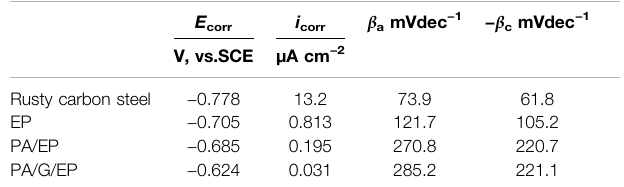
TABLE 2 | Corrosion parameters of rusty carbon steel, EP, PA/EP, and PA/G/EP immersed in 3.5 wt% NaCl solution after 240 h.